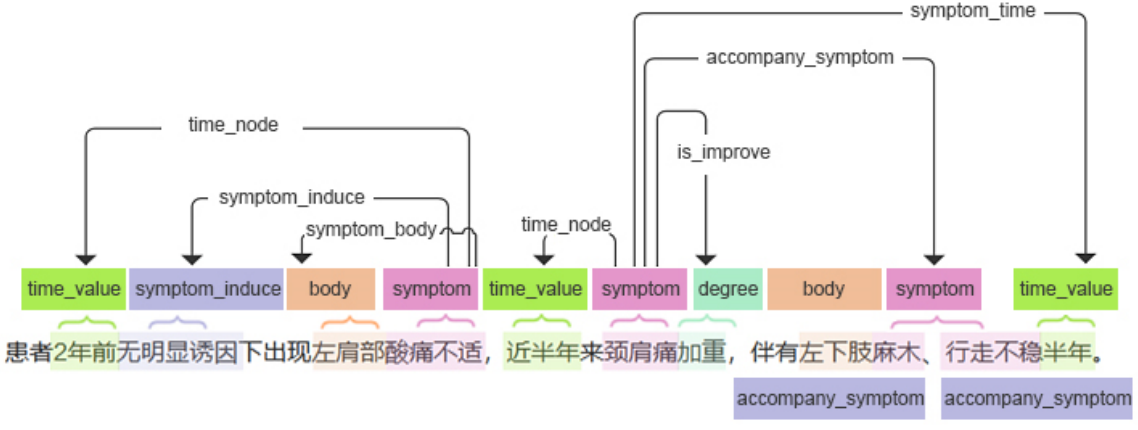
Figure 1. Clinical information extraction based on a bidirectional recurrent neural